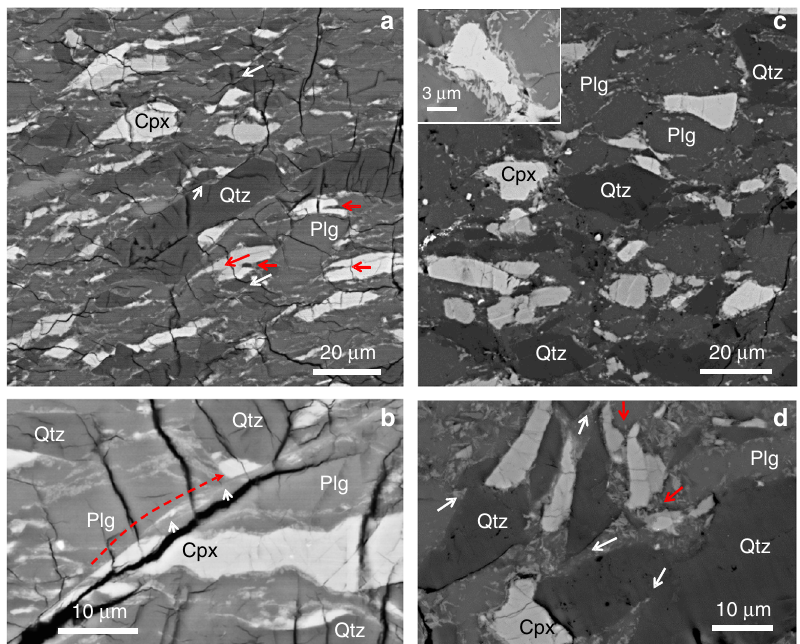
Fig. 6 SEM micrographs of samples deformed at 1073 K. All images are oriented with the shortening direction vertical. a , b D1996 (G sample). a Note predominant NE-SW lighter linear features (NRBs) along grain boundaries which are fi lled with nm sized reaction products. Many grains are torn open with small “ notches ” . Red and white arrows indicate some notches in Cpx and Qtz, respectively. b A Cpx grain has been sheared off. Red dashed arrow show that the broken-off portion has a displacement of ~20 μ m. A thin trace of reaction products can be seen connected the two parts of the grain. c , d D1787 (EG sample). c More reaction products are along Cpx grain boundaries compared to a . Inset shows details of reaction rim around a Cpx grain. The needle- shaped reaction grains are Ky. d Cpx and Qtz grains are frequently associated with triangular shaped Plg wedges fi lled with reaction products (red and white arrows point to wedges in Cpx and Qtz grains,